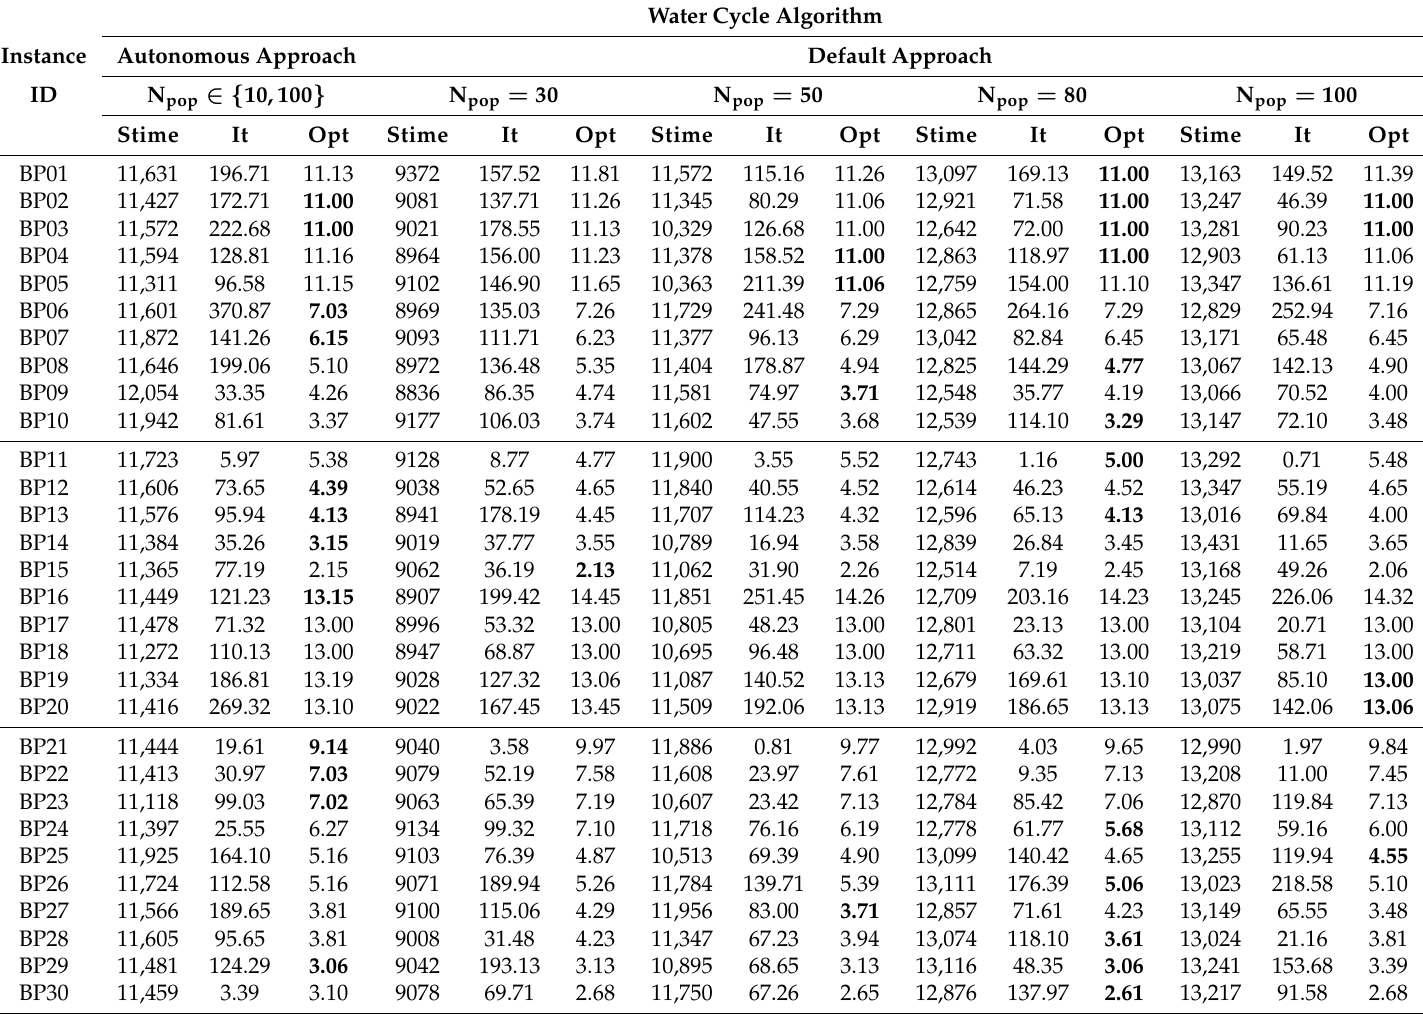
Table 6. Results solving the Boctor’s instances (1/3). Water Cycle